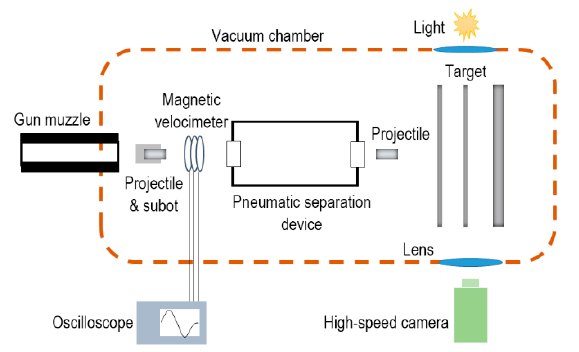
Figure 3. The two stage light-gas gun and magnetic velocimeter in Beijing Institute of Technology (BIT).